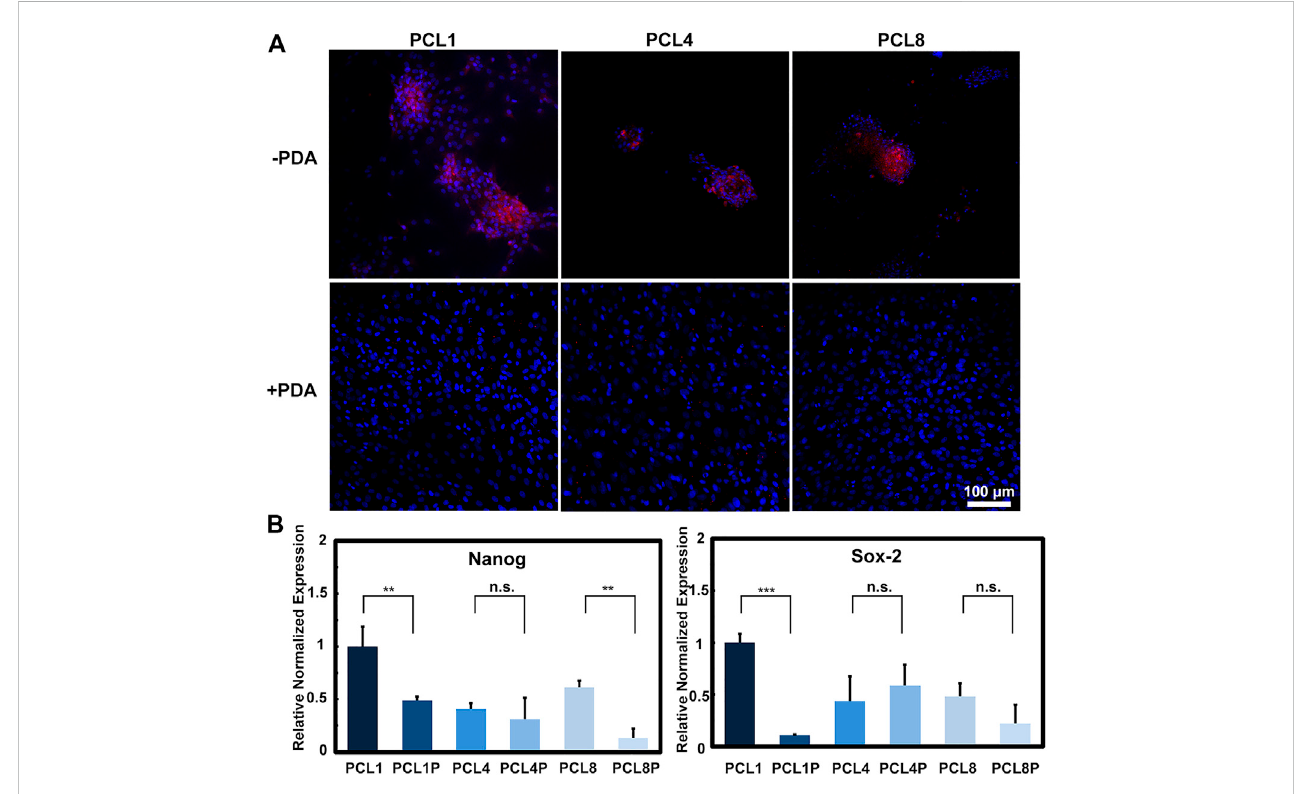
FIGURE 3 The multipotency of BMMSCs after being cultured on different substrates for 14 days. (A) Immuno fl uorescence staining of Nanog protein (red: Nanog, blue: Nuclear) ( n = 3) and (B) gene expressions of Nanog and Sox-2 of the cultured cells ( n = 4).